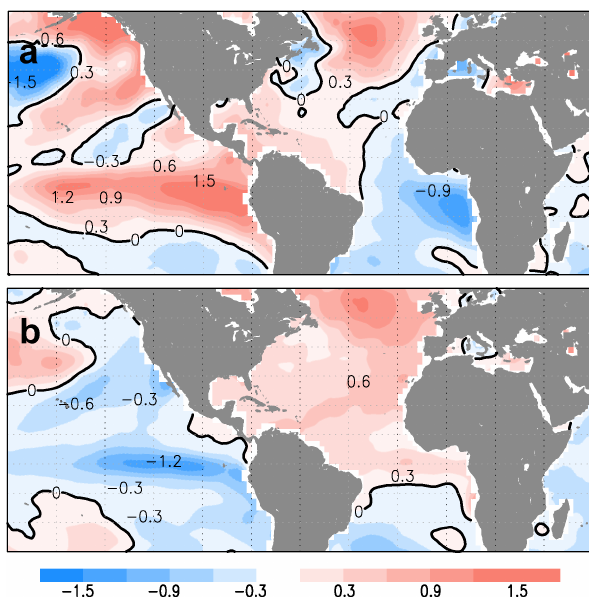
Fig. 11. Composite maps of SST for R95pTOT (PC1) (a) and for the AMO (b) in